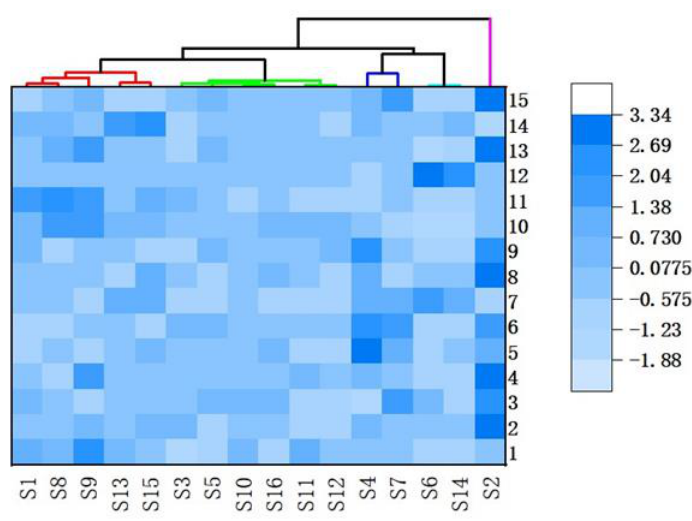
Figure 4. Cluster analysis heat map of Echinacea purpurea (L.) Moench.